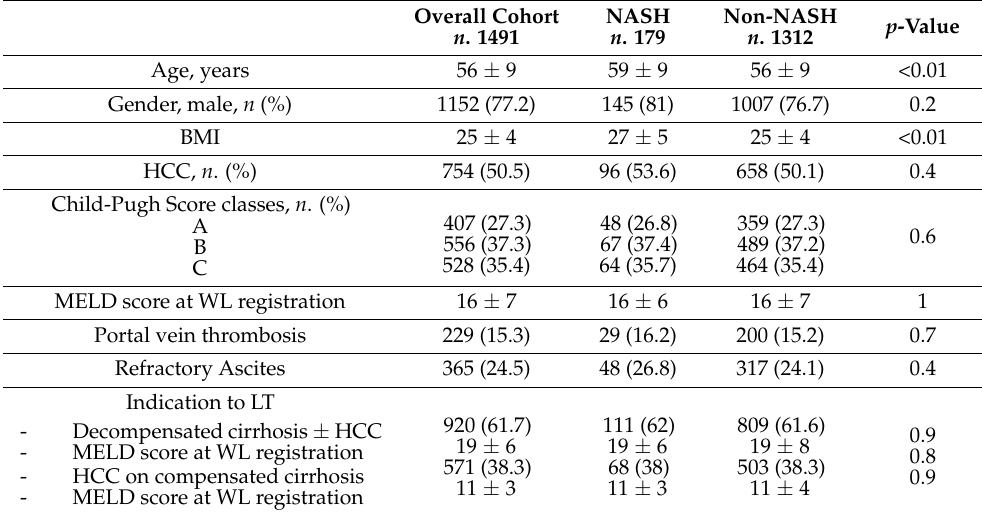
Table 1. Clinical characteristics of the patients at the time of the waiting list, according to the underlying etiology. Abbreviations: BMI: body mass index; HCC: hepatocellular carcinoma; LT: liver transplantation; MELD: model for end stage liver disease; NASH: non-alcoholic steatohepatitis; WL: waiting